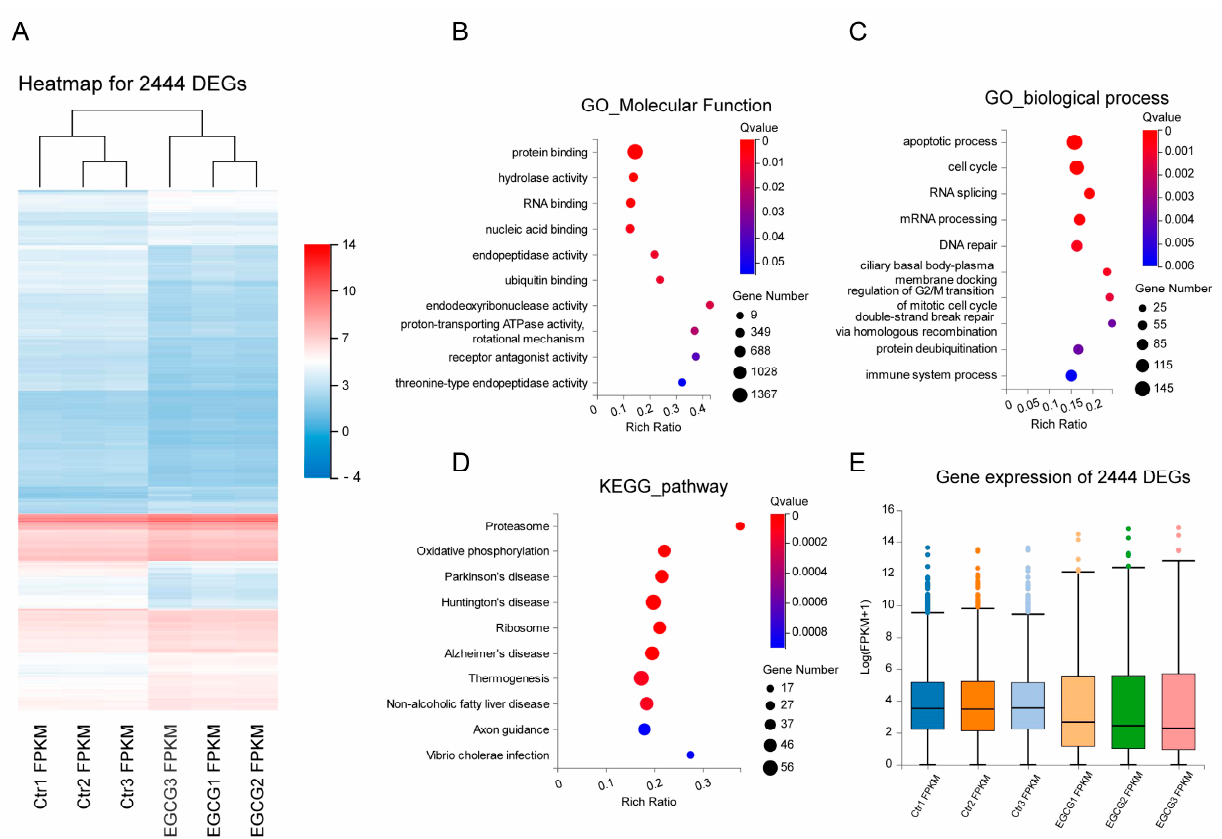
Figure 2. Analysis of 2440 differentially expressed genes (DEGs). ( A ) Heatmap showing the expres- sion patterns before and after EGCG treatment. ( B ) GO analysis of molecular function for DEGs. ( C ) GO analysis of the biological process for DEGs. ( D ) KEGG pathway enrichment for DEGs. ( E ) The expression level of DEGs before and after EGCG treatment.